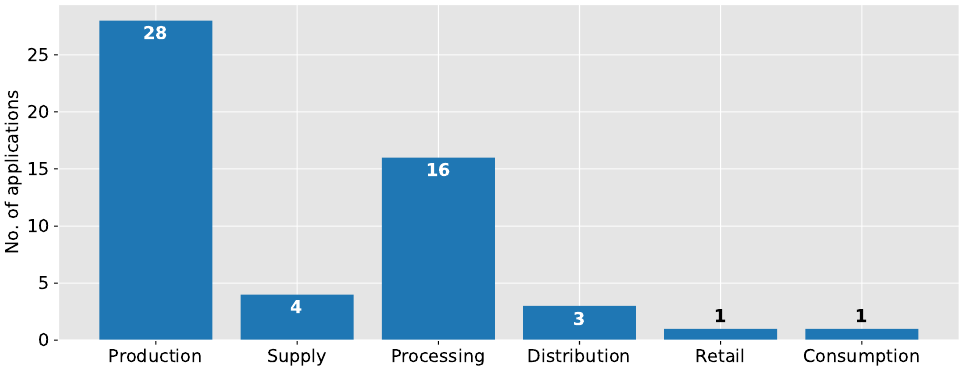
Figure 6. Results of the literature review–Absolute frequency of digital twin applications assigned to stages in the food supply chain. As there are applications [47,56] assigned to several stages, the total number of counts is 53 although 51 applications were found in 38